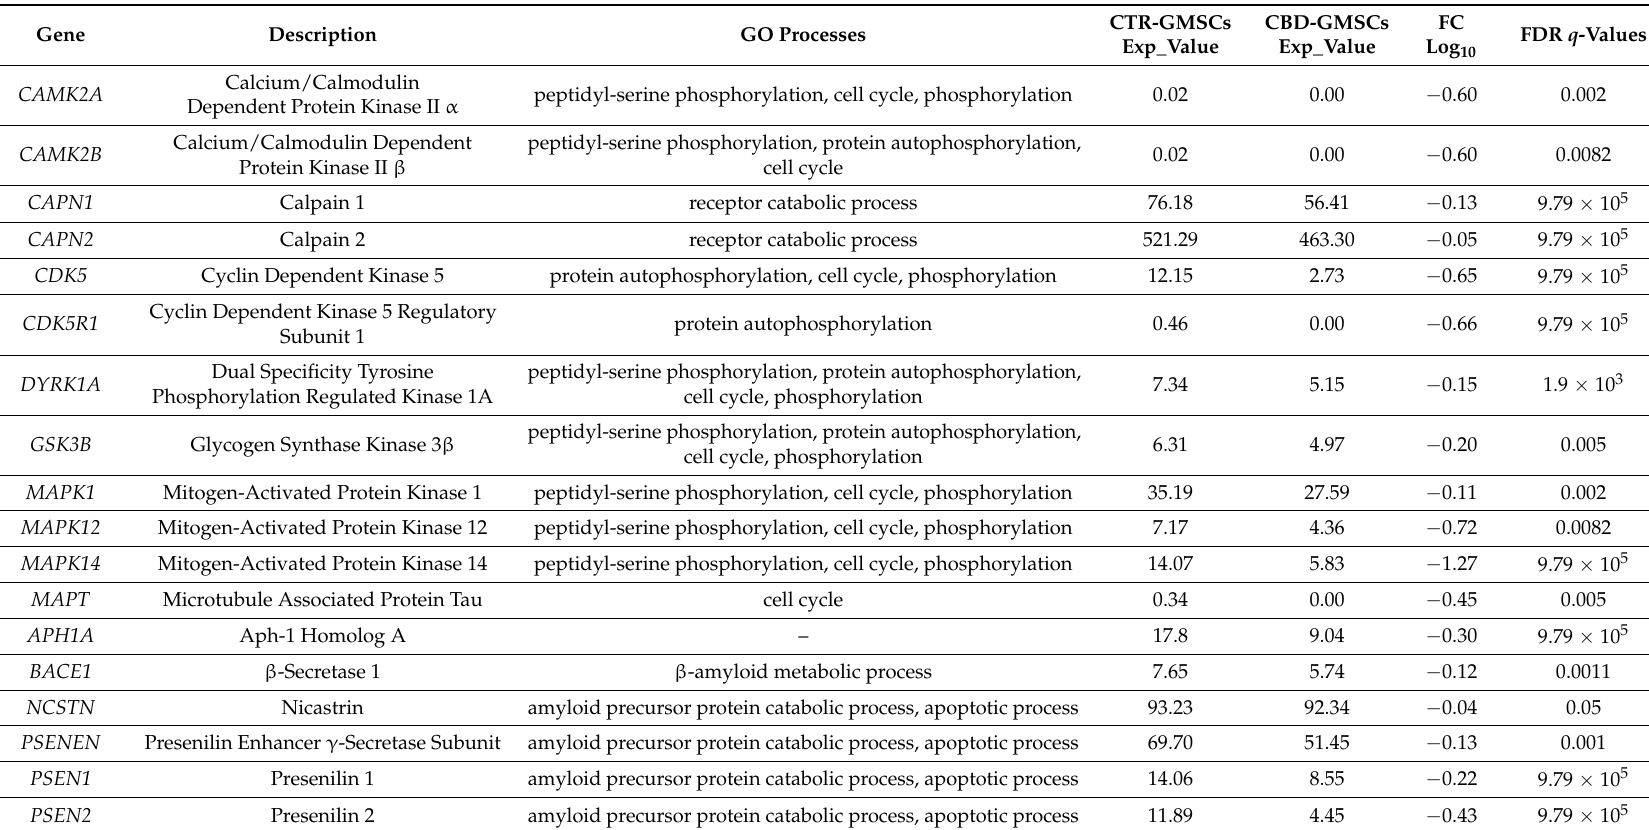
Table 1. CBD treatment downregulated the expression of kinases involved in tau phosphorylation in GMSCs. The differential expression between CBD-GMSCs and CTR-GMSCs is given in Fold Change expressed in logarithm with base 10 (FC Log 10 ). Gene ontology (GO) processes indicate the gene classification in different biological processes. Instead, the statistical significance is indicated by the False Discovery Rate (FDR), q -values ≤ 0.05 were considered statistically